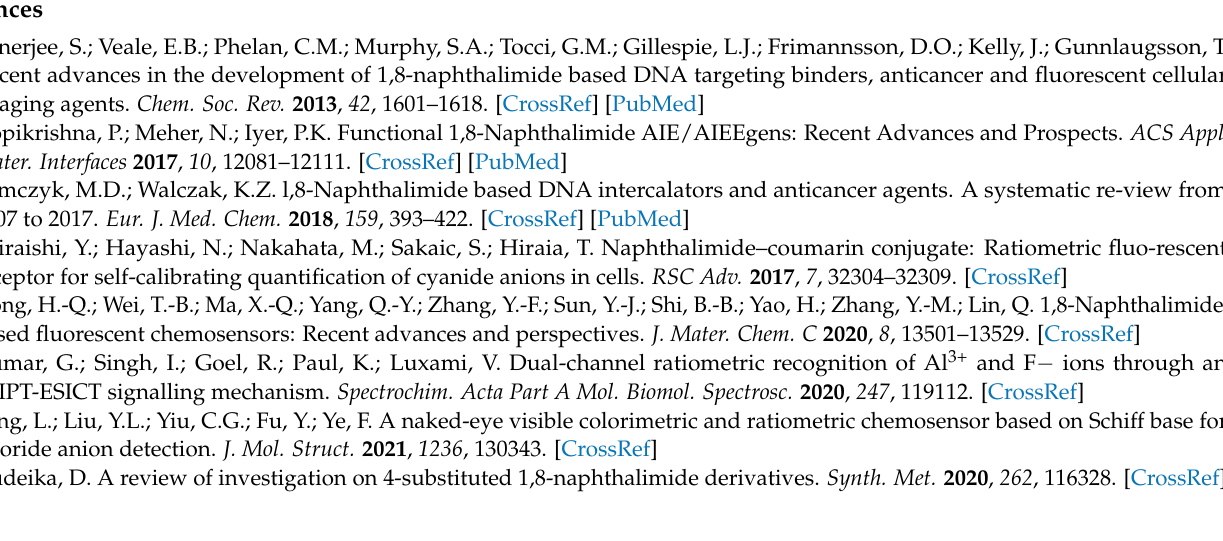
the solvents mixture. Photographs were taken under 366 nm UV irradiation from a hand-held UV lamp. Figure S12: Effect of TFA on photoluminescence (PL) properties of imines (AzNI-1,3,4,5) in chloroform (CHCl 3 ): (a) superimposed spectra at excitation 340 or 430 nm, (b) λ em intensity versus equivalent of TFA. Photographs were taken under 366 nm UV irradiation from a hand-held UV lamp. Figure S13: Effect of TFA on photoluminescence (PL) properties of imines (AzNI-1,3,4,5) in acetonitryle (CH 3 CN): (a) superimposed spectra at excitation 340 or 430 nm, (b) λ em intensity versus equivalent of TFA. Photographs were taken under 366 nm UV irradiation from a hand-held UV lamp. Figure S14: Effect of TFA on photoluminescence (PL) properties of imines (AzNI-1,3,4,5) in mathanol (CH 3 OH): (a) superimposed spectra at excitation 340 or 430 nm, (b) λ em intensity versus equivalent of TFA. Photographs were taken under 366 nm UV irradiation from a hand-held UV lamp. Figure S15: Effect of TFA on photoluminescence (PL) properties of imine AzNI-6 in chloroform (CHCl 3 ), acetonitryle (CH 3 CN) and methanol (CH 3 OH): (a) superimposed spectra at excitation 340 or 430 nm, (b) λ em intensity versus equivalent of TFA. Photographs were taken under 366 nm UV irradiation from a hand-held UV lamp. Figure S16: Emission spectra for the tested compounds in chloroform at various concentrations (from 100 to 1 µ M) at excitation 340 nm (black line) and 430 nm (red line). Measurements were performed for the same measurement conditions. Figure S17: Excitation and emission spectra for the tested compounds in methanol at various concentrations (100 and 10 µ M). Measurements were performed for the same measurement conditions. Figure S18: Co-localization fluorescence images of AzNI-3 at a concentration of 25 µ M and ERTracker Red dye in MCF-7 cells. The images acquired under 470 nm (for AzNI-3) and 587 nm (for ER-dye) LED illumination. Scale bars indicate 25 µ